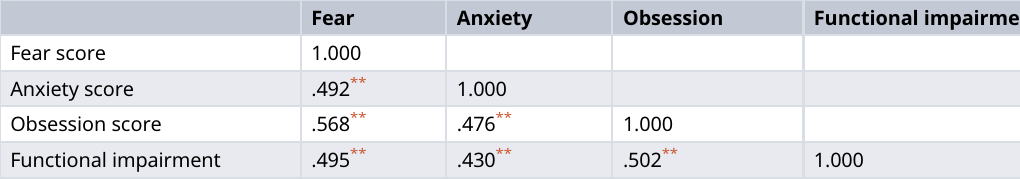
Table 6. Correlation